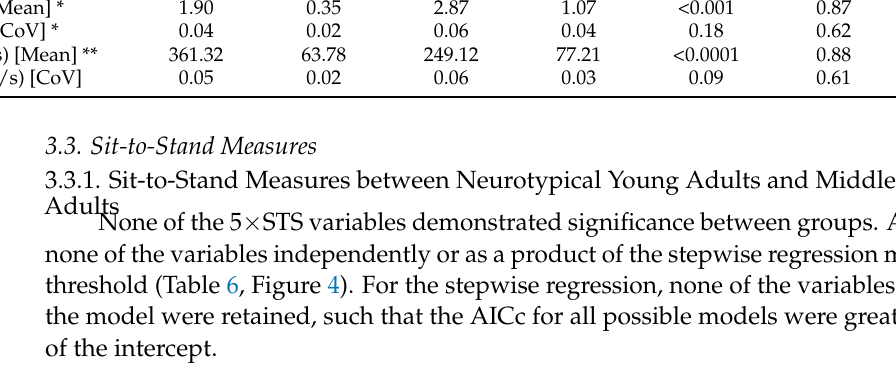
Table 6. Means, standard deviations, significance ( p ), independent AUC (I-AUC), and stepwise AUC (S-AUC) measures for 5 × STS variables. Variable(s) with a single (*) were included in the stepwise regression.